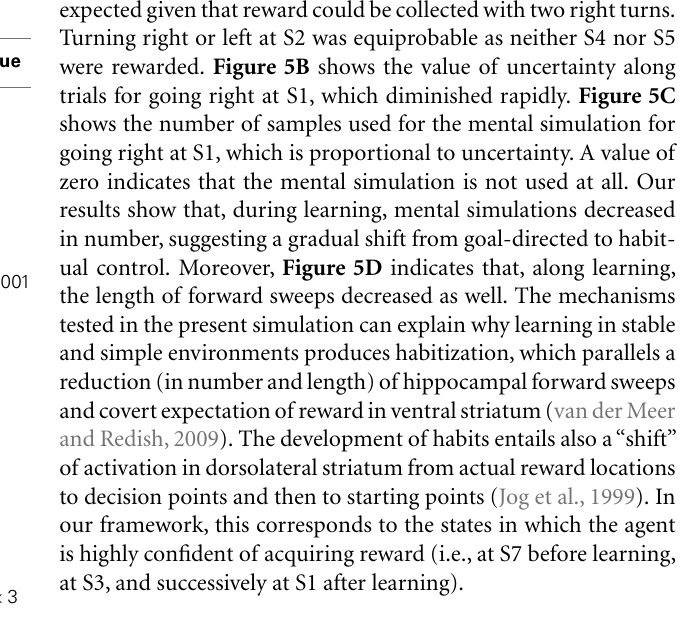
Table 2 | Parameters and constants used in all the